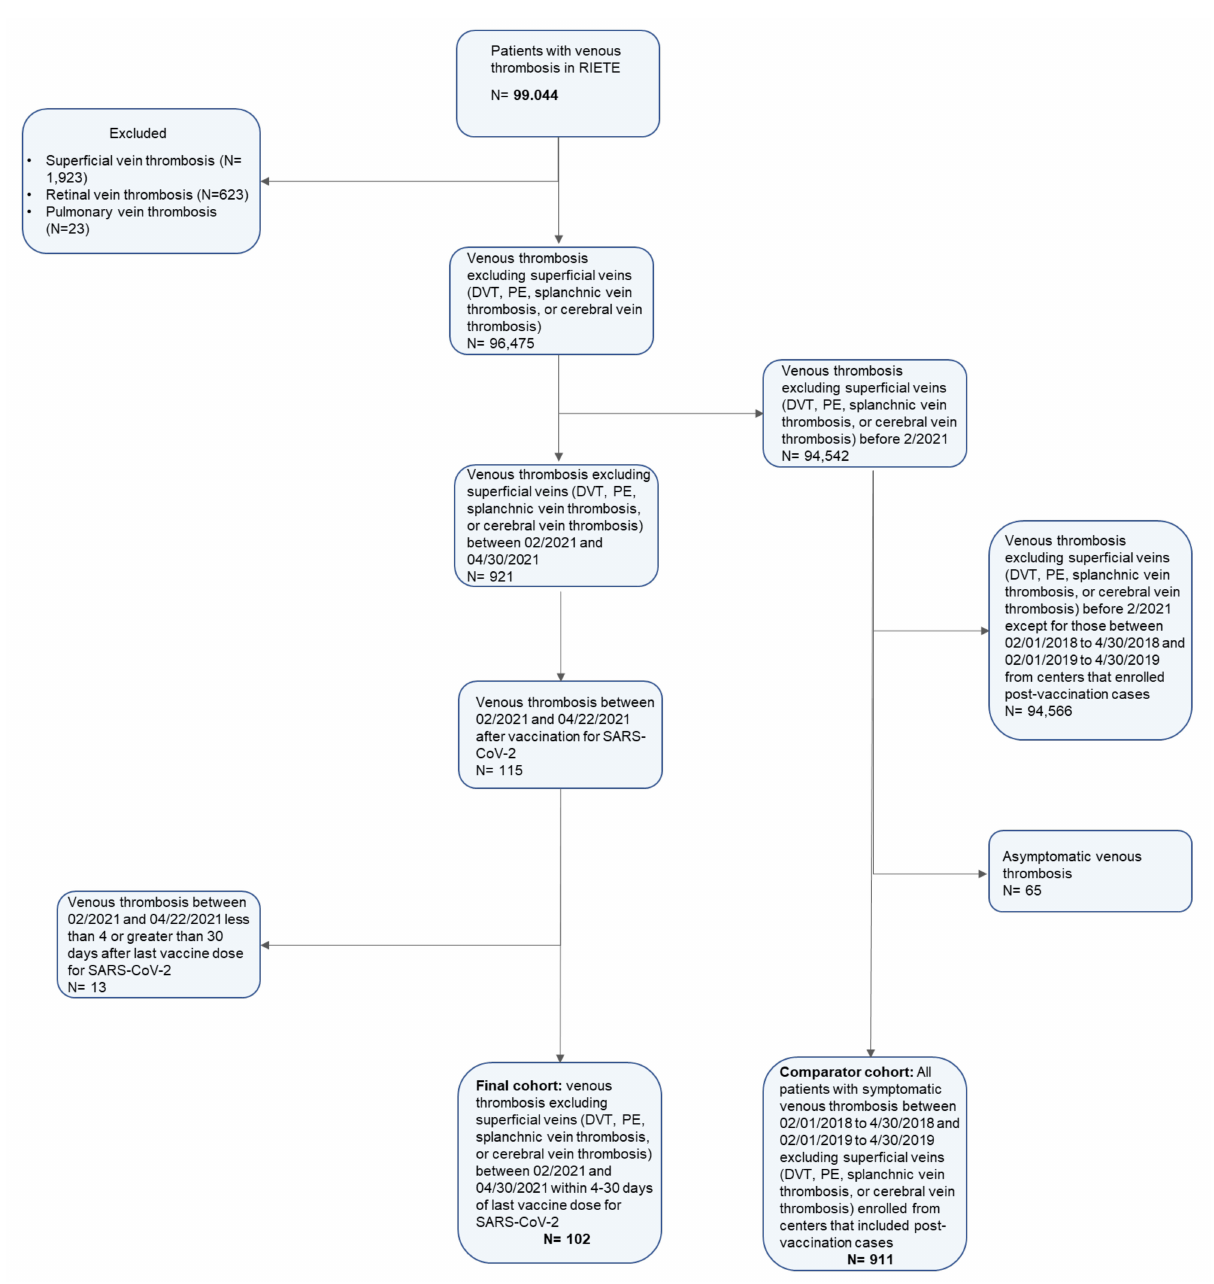
Figure 1. Study Flow Diagram. N: sample